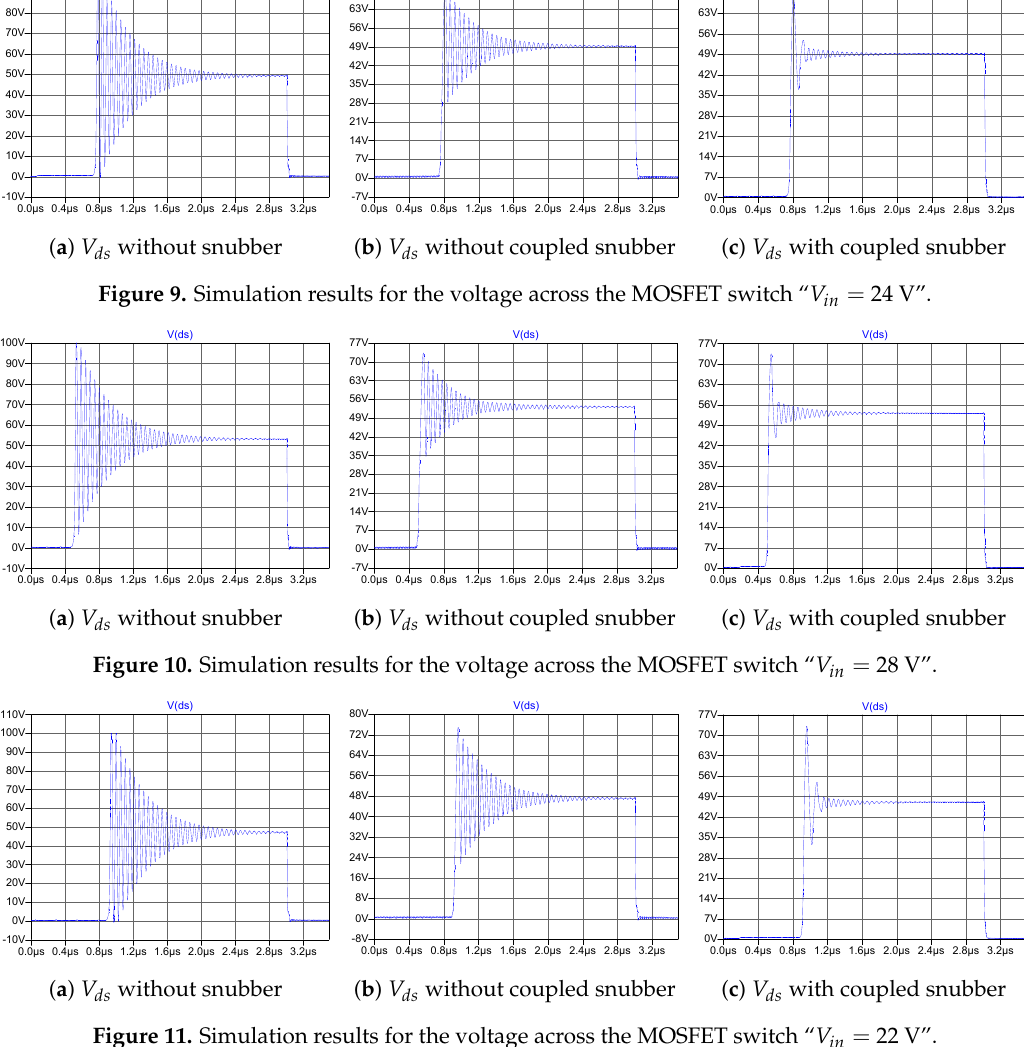
Figure 11. Simulation results for the voltage across the MOSFET switch “ V in = 22